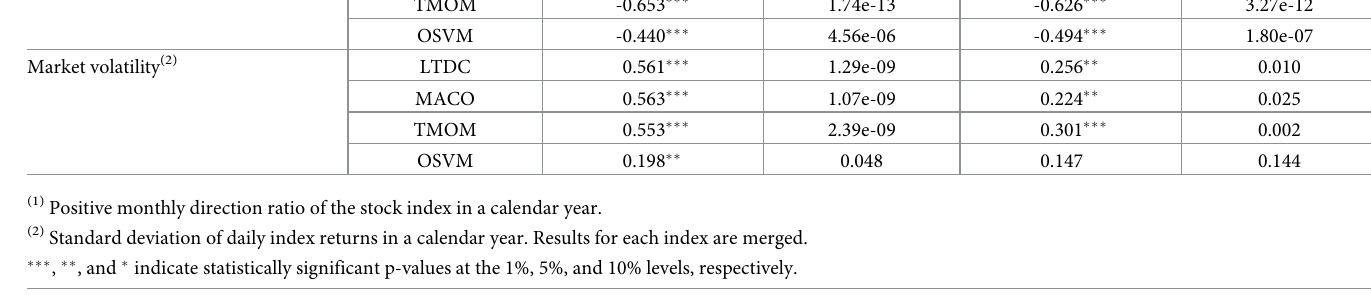
Table 4 confirms the correlation between the volatility level of the index and the excess return of each rule, where the average daily standard deviation of each stock index in a year represents market volatility. However, the coefficients and significance are smaller than those of the posi- tive direction ratio. This is consistent with the results in Tables 2 and 3, which indicate that the